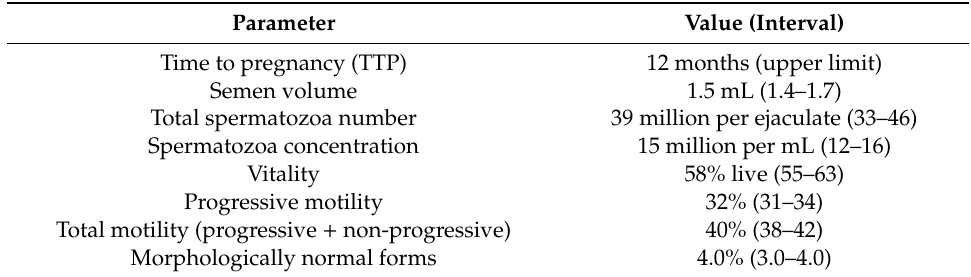
Table 2. Semen characteristics in normozoospermic men. Data is according to the World Health Organization reference values [9]. Data indicate lower reference limits, the fifth centiles (with 95% confidence intervals). Time to pregnancy (TTP) is defined as the number of months elapsed between stopping contraception to achieving a pregnancy